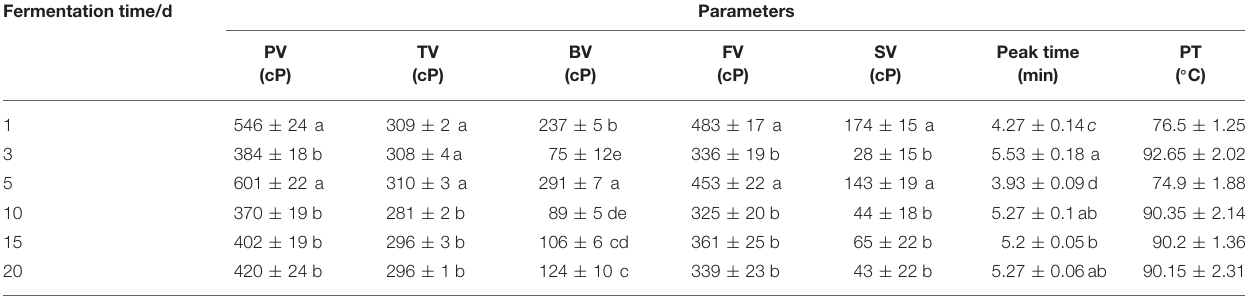
Meanandstandarddeviationofthreereplicates.EquallettersinthecolumnsdonotdifferintheStudent’st-testwithasignificance levelp < 0.05.PV,peakviscosity;TV,troughviscosity; BV, viscosity breakdown; FV, final viscosity; SV, setback viscosity; Peak time, time for maximum peak viscosity; PT, pasting